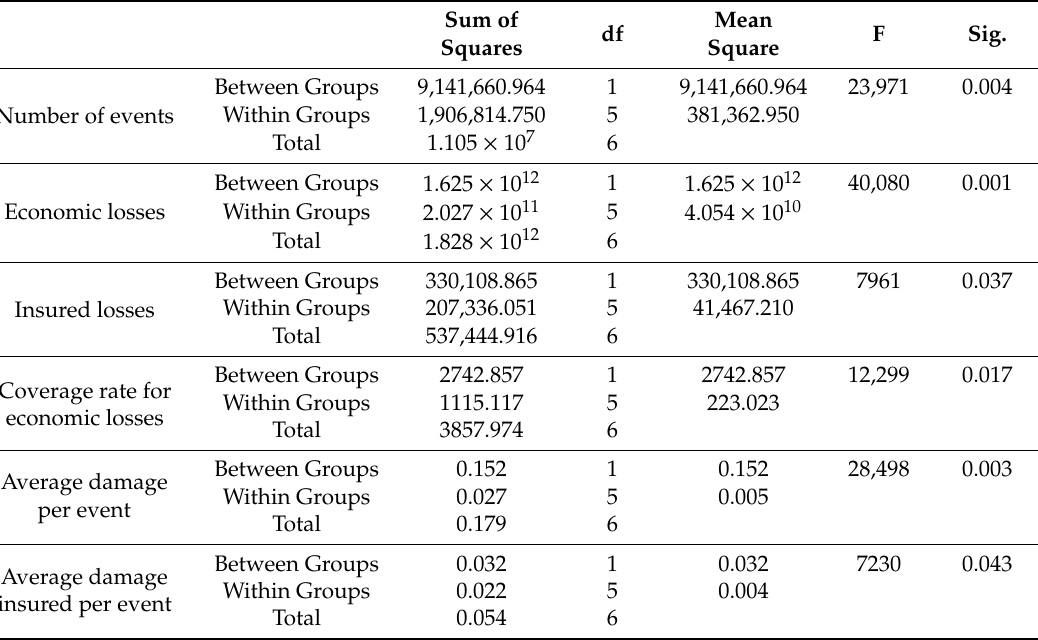
Table 3. ANOVA for the group before / after 1990.